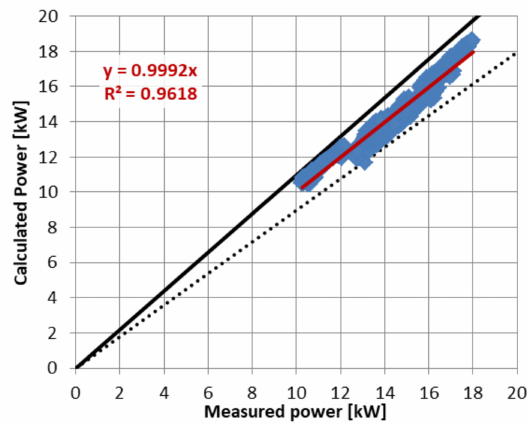
Figure 7. Result of model calibration prior to scaling test 2 (data set Lab-Cal2), measured vs. calcu- lated thermal power of cooling tower; black solid/dotted lines show +/ − 10%